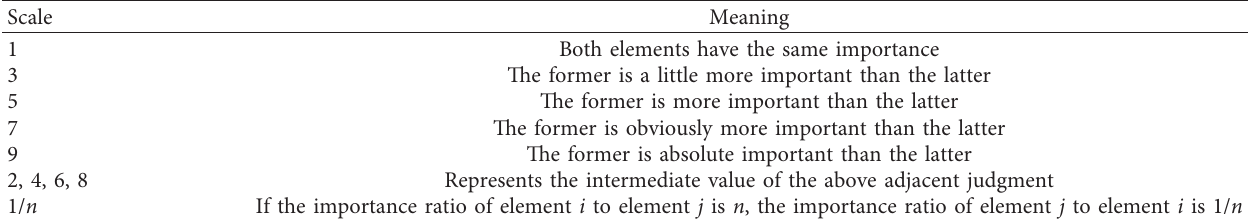
Table 1: 1–9 proportional scale method and its